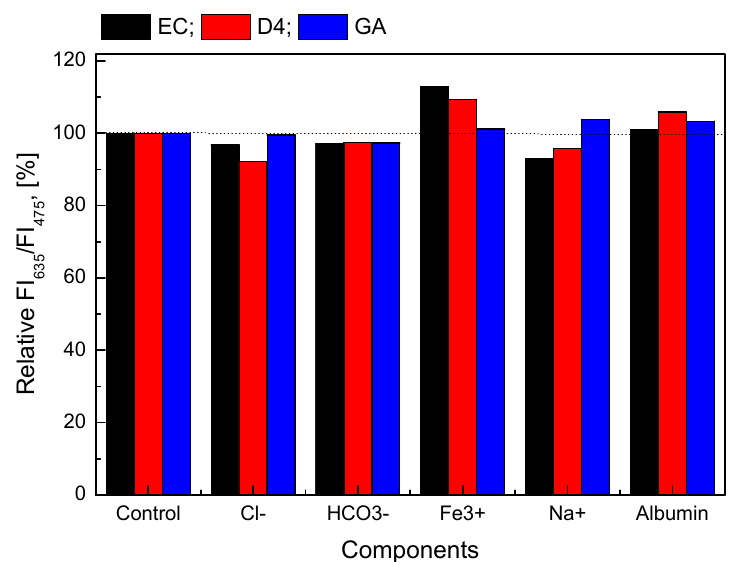
Figure 9. Relative response of GOD = PS@C6^PtP membranes with different supporting materials (EC, D4, and GA) at 1 mM glucose in the presence and the absence of 106 mM/L Cl − , 30 mM/L HCO 3 − , 1.625 mg/L Fe 3+ , 145 mM/L Na + , and 5 g/dL BSA.